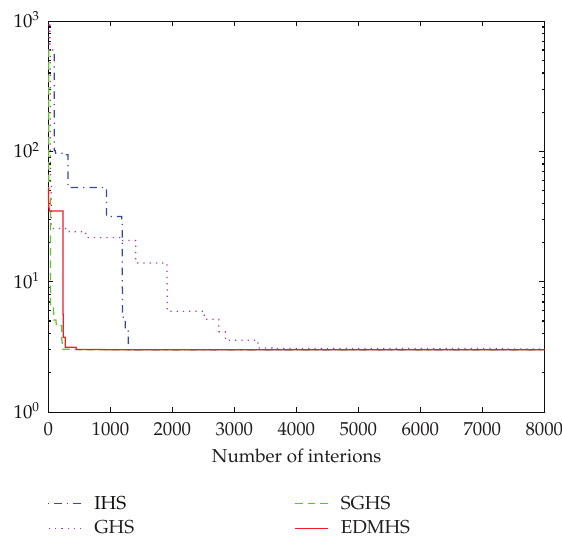
Figure 2: Convergence of Goldstein and Price function